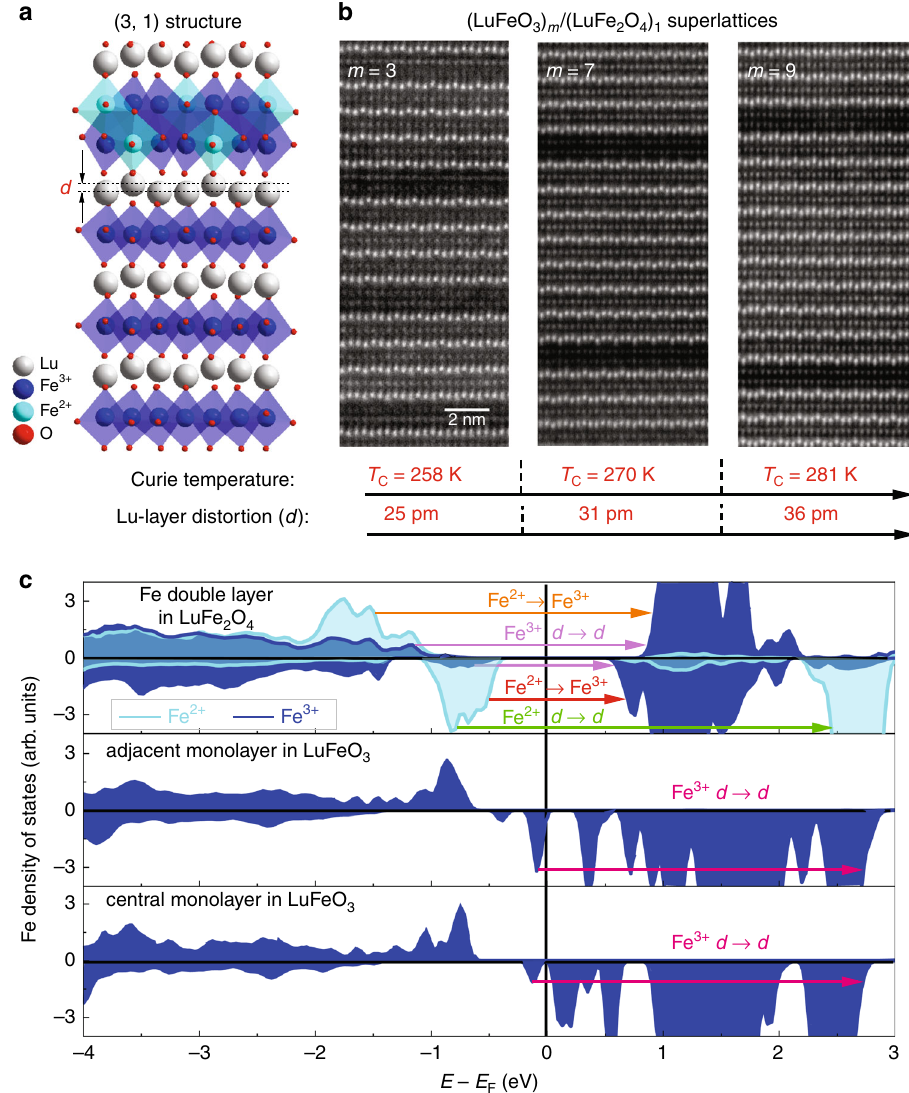
Fig. 1 Crystal structure, growth pattern, and spin-projected density of states. a Crystal structure of the (3, 1) fi lm showing how a LuFe 2 O 4 slab (which has an iron oxide double layer with both Fe 2 + and Fe 3 + between two Lu layers) is sandwiched between three layers of LuFeO 3 20 . d represents the Lu-layer displacement. b HAADF-STEM images of the m = 3, 7, and 9 superlattices viewed along the [110] zone axis. Atomic number contrast shows the bright, heavy lutetium atomic rows layered with the less bright iron atomic rows. The scale bar is the same for all images. Trends in the ferrimagnetic T C and Lu- layer distortion (which increases with the number of LuFeO 3 layers) are also shown. c Spin-projected density of states of the Fe double layer in LuFe 2 O 4 , an adjacent monolayer of LuFeO 3 and the central LuFeO 3 monolayer. These calculations were performed using the self-doped charge-ordering model as discussed in the text (Fig. 4b). The Fe double layer is nonpolar, and the Lu-layer displacement is asymmetric with both down/up/up and down/up/down distortion patterns around the Fe bilayer. The Fe 3 + and Fe 2 + states are indicated with dark and light blue, respectively. The arrows denote different types of excitations.